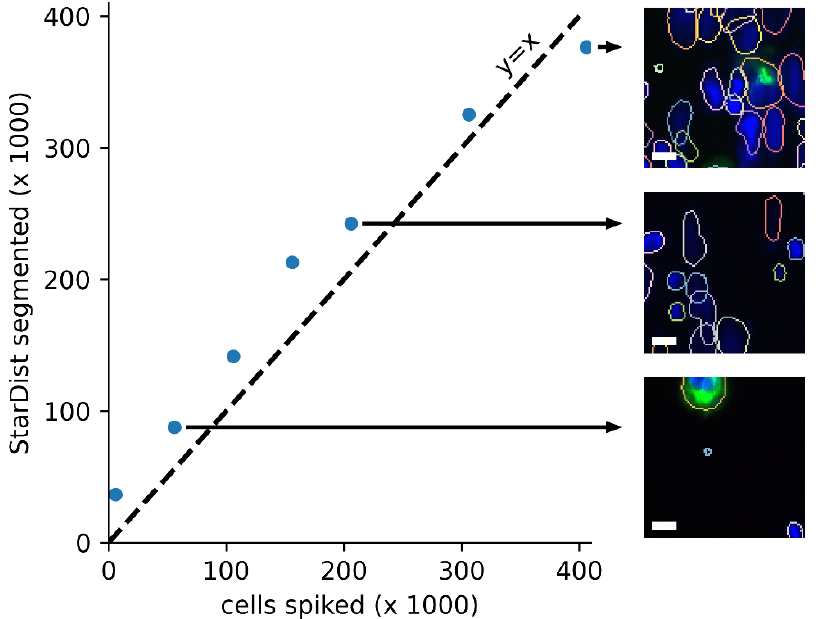
Figure 3. Performance of StarDist segmentation on increasing numbers of spiked cells. Comparison of number of spiked cells in the cartridge versus the number of events detected by Stardist showing a good correlation up to the maximal density that can be imaged using the CellTracks Analyzer II (scale bar is 10 µm).